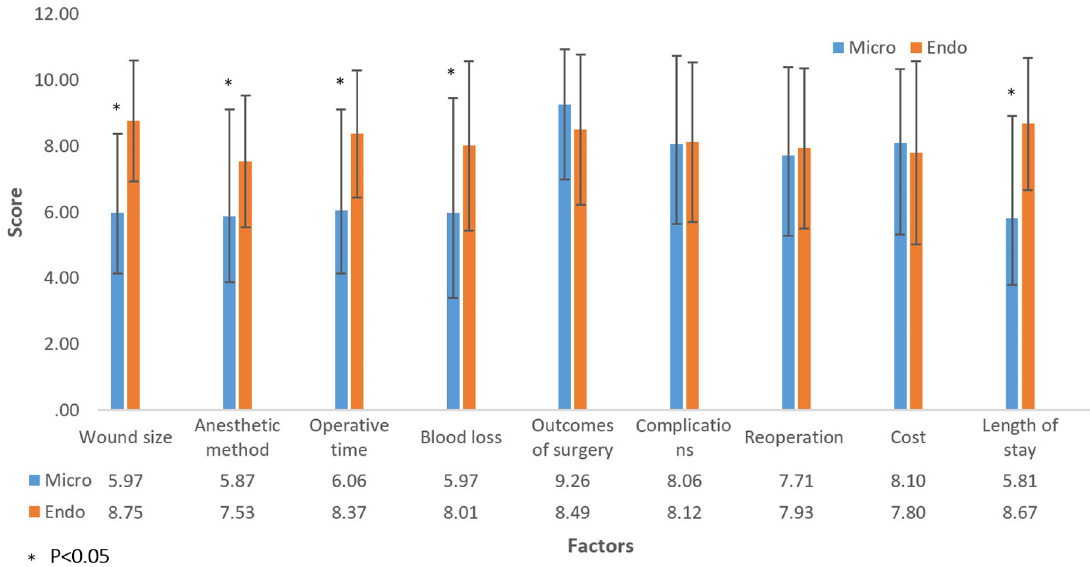
Fig 1. Opinions of the participants who had no experience in lumbar discectomy for how important of these factors to select the microscopic lumbar discectomy or endoscopic lumbar discectomy [Scale from 1 (least important) to 10 (most important)].